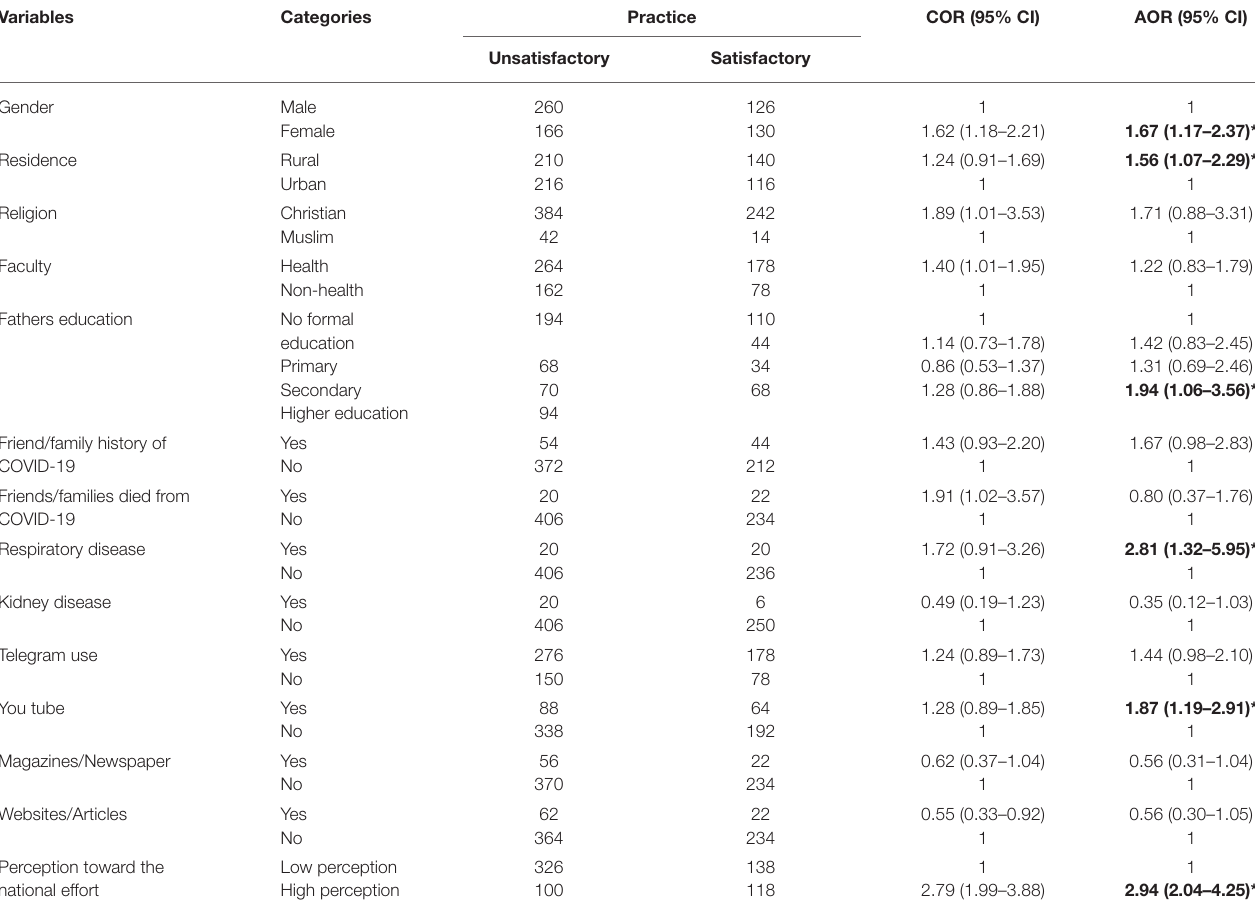
TABLE 4 | Factors of COVID-19 prevention behaviors,